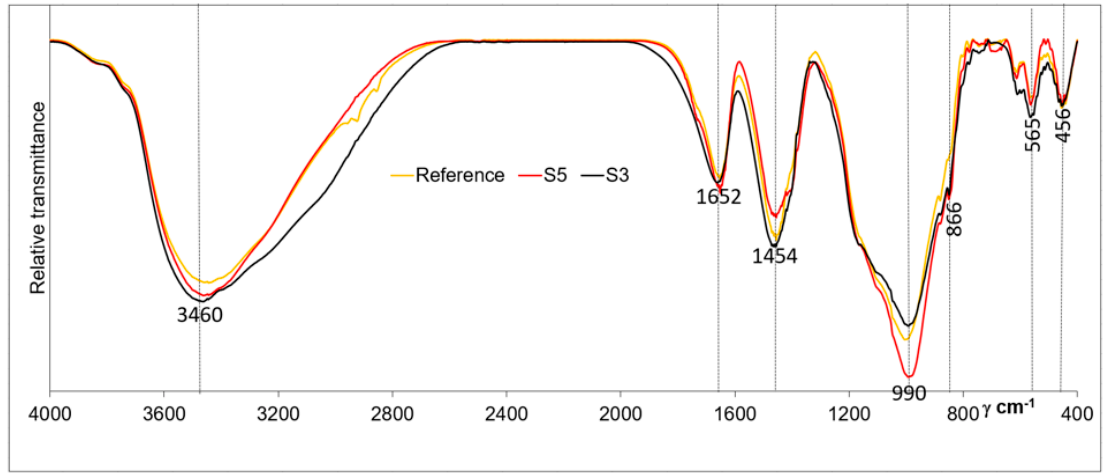
Figure 6. FTIR spectra of hardened cement paste samples containing zeolitic by-product after 28 days of hydration.